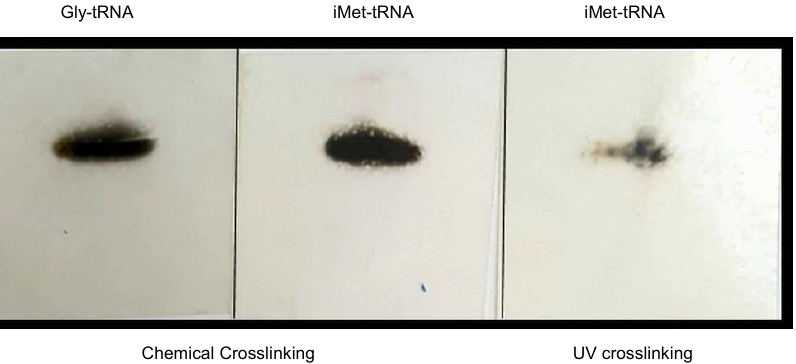
Figure 2: Northern blot for detection of methionine initiator tRNA. Equal amounts (30 μg) of RNA sample was resolved on a denaturing urea polyacrylamide gel and subjected to either EDC based chemical crosslinking or traditional UV based crosslinking after electro-blotting to the nylon